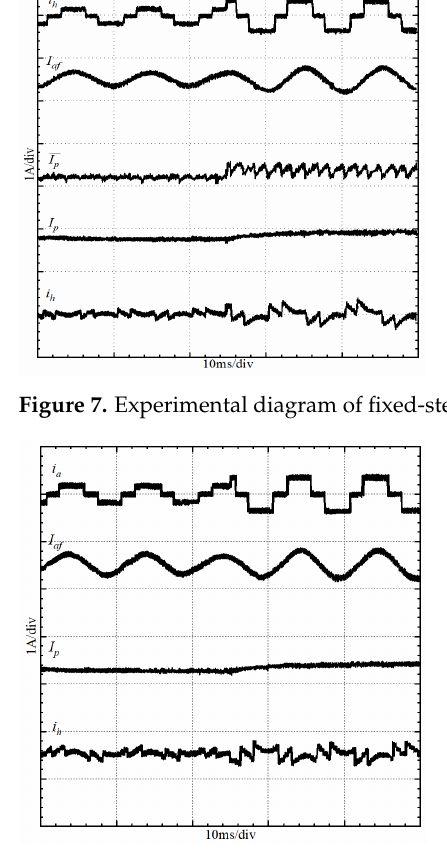
Figure 8. Experimental diagram of Butterworth